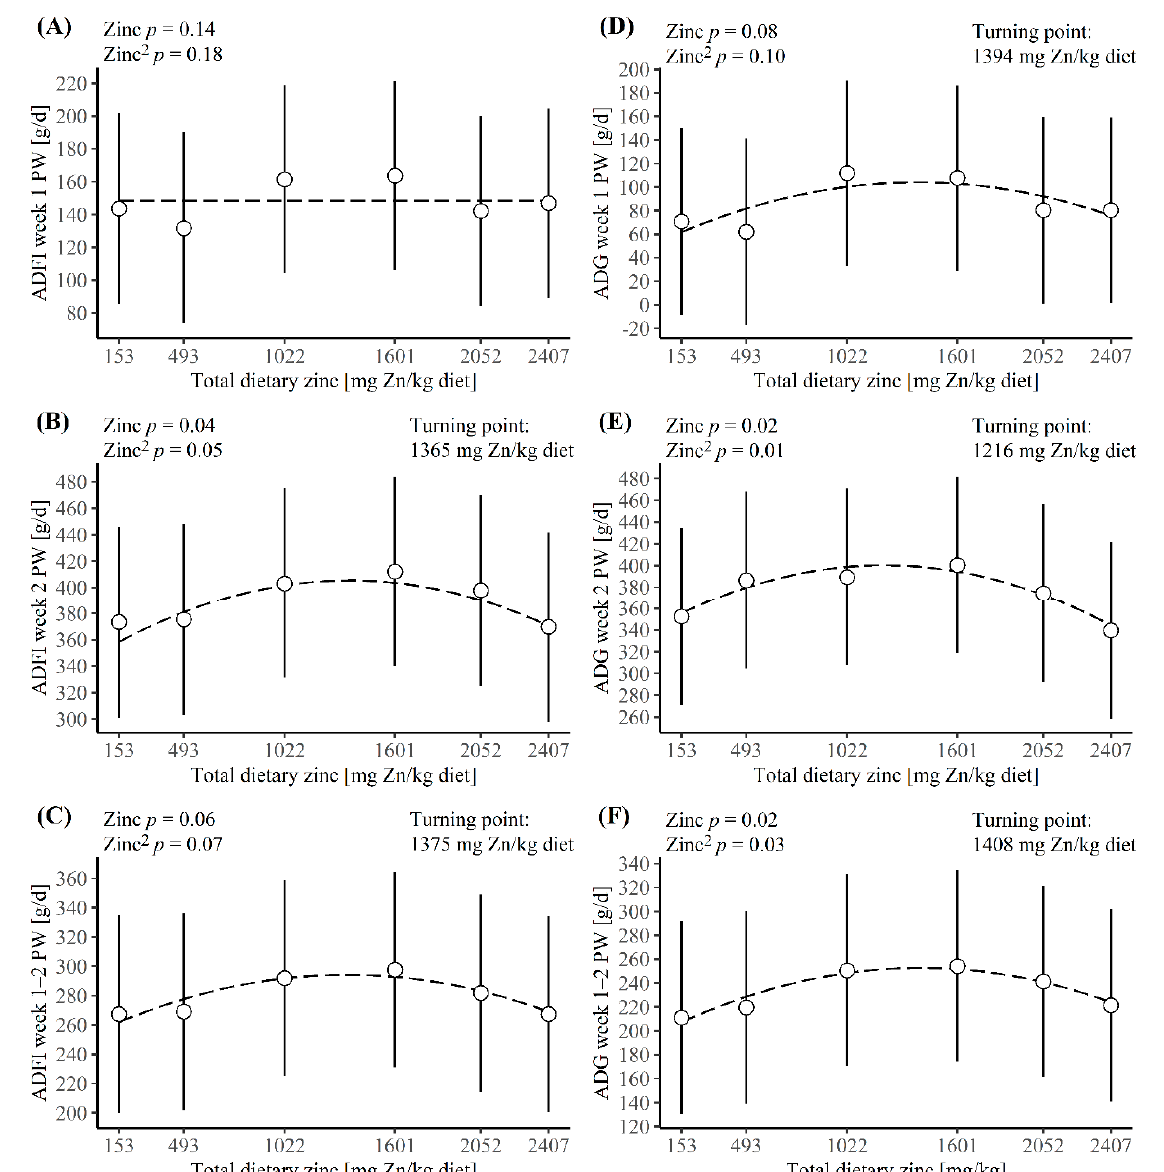
Figure 1. The average daily feed intake (ADFI) and average daily gain (ADG) obtained with six dietary zinc concentration during ( A , D ) the first week post-weaning (PW), ( B , E ) the second week PW and ( C , F ) the two first weeks PW. The dashed lines illustrate the effect of dietary zinc concentration on ADFI or ADG. The turning point and p -value of the linear and quadratic parameters are denoted at the top of each graph.